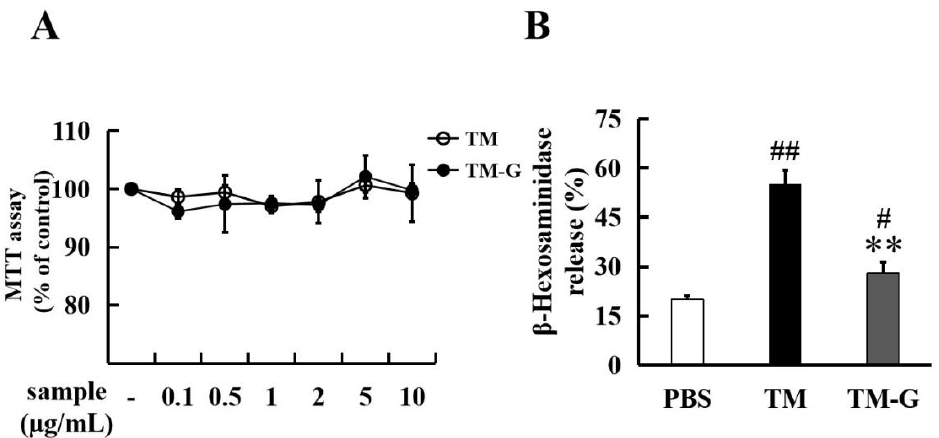
Figure 3. Bioavailability analysis of TM-G using RBL-2H3: ( A ) Cell viability analysis of TM and TM-G with different concentrations (0, 0.1, 0.5, 1, 2, 5, 10 μ g/mL). ( B ) Effects of TM and TM-G on the release of β -hexosaminidase. All data are presented as the mean ± SD ( n = 3). # p < 0.05 and ## p < 0.01 was used to compare with PBS group. ** p < 0.01 was used to compare with TM group.